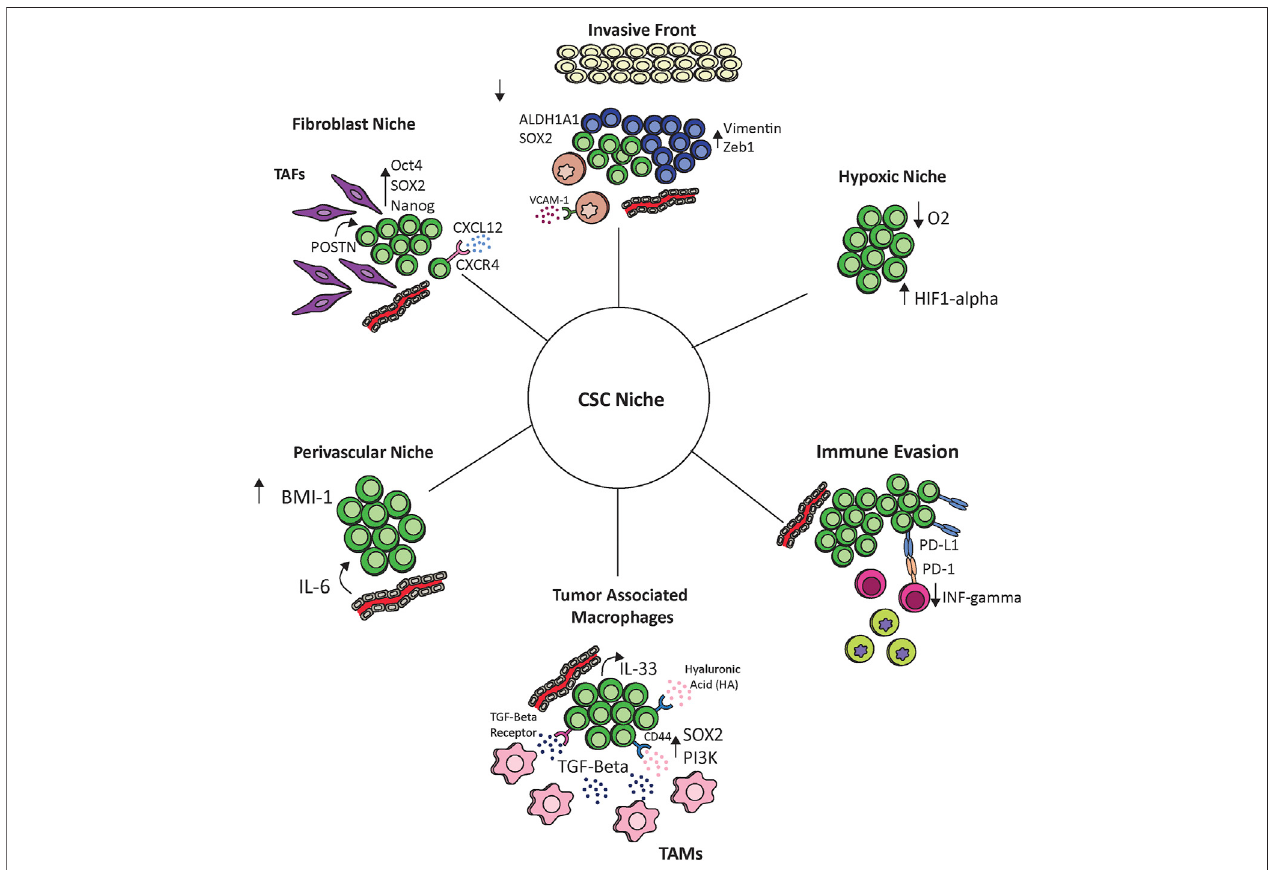
FIGURE1| Theinteractionofcancerstemcellswiththetumormicroenvironment.Cancerstemcellscommunicatewithandreacttothetumorecosystemincluding endothelial cells, hypoxic environments, tumor associated fi broblasts (TAFs), tumor associated macrophages (TAMs), monocytes, and other immune cells. These interactions maintain the cancer stem cell niche and provide potential therapeutic options.